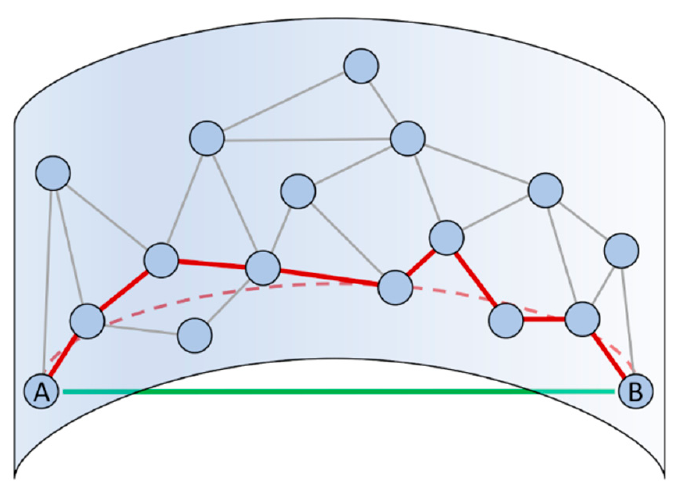
Figure 3. Schematic representation of the di ff erence between the Euclidean and geodesic distance (green solid and red dashed lines, respectively) evaluated in a curved manifold. The network-based nearest neighbor approximation of the geodesic distance provided by Isomap is also shown (red solid lines).